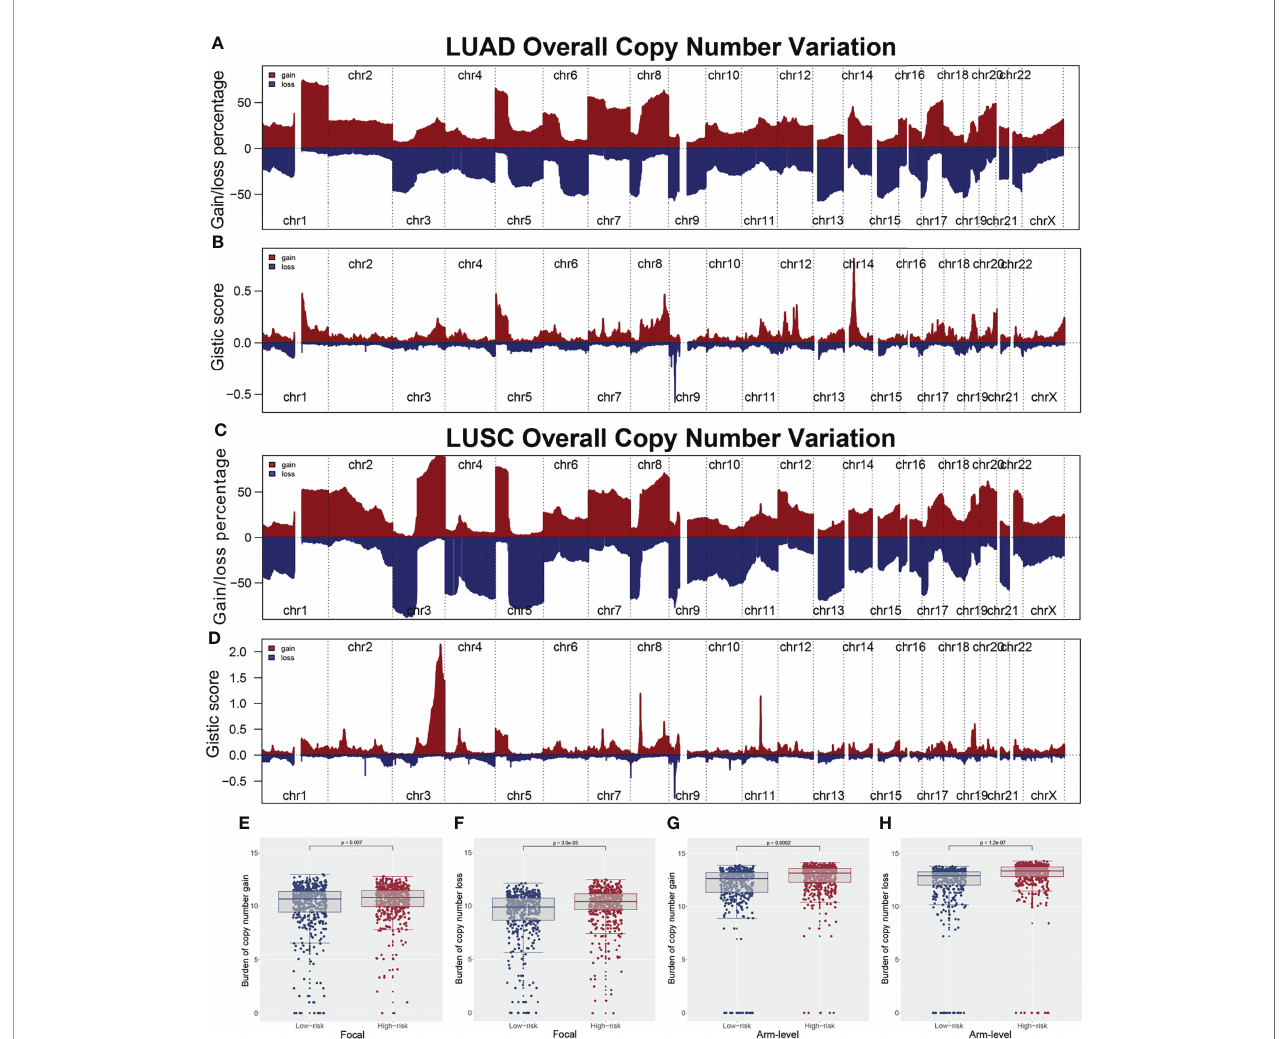
FIGURE 5 | Copy number variation of TCGA-LUAD and TCGA-LUSC. (A, B) Copy number pro fi les (gain and loss) and gistic score of TCGA-LUAD; (C, D) Copy number pro fi les (gain and loss) and gistic score of TCGA-LUSC; (E, F) The copy number burden in focal level between low and high risk patients; (G, H) The copy number burden in arm level between low and high risk